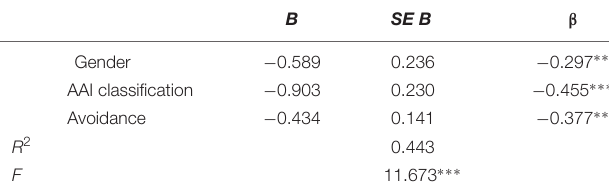
TABLE 4 | Multiple regressions predicting free MG